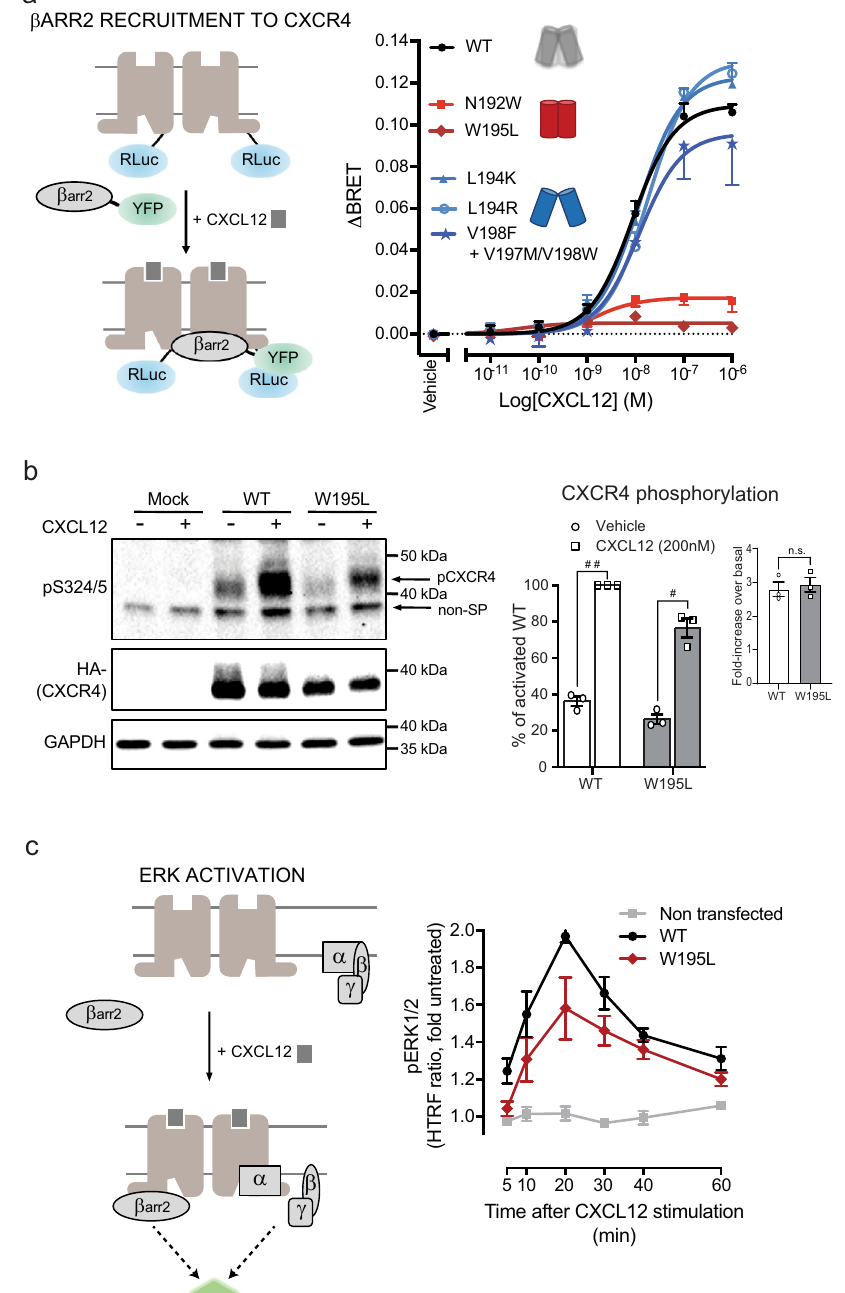
Fig. 4 | β -arrestin recruitment and ERK activation. a (Left) Schematic repre- sentation of the BRET-based ligand-induced β -arrestin-2 ( β arr2) translocation assay.(Right)CXCL12-promoted β arr2recruitmenttoCXCR4measuredbyBRETin HEK293TcellstransfectedwithCXCR4-RLuc,WTormutantasindicated,and β arr2- YFP. BRET 480-YFP between CXCR4-RLuc and β arr2-YFP was measured after the addition of coel-h (10min) and CXCL12 (15min). Data shown represent the mean±SEM of at least three independent experiments and are represented as Δ BRET. b (Left) Phosphorylation at S324/5 of WT and W195 5.34 L CXCR4 promoted by stimulation with 200nM CXCL12 for 30min detected using an anti pS324/5 antibody (pCXCR4 indicates the CXCR4-S324/5 phosphorylation band; non-SP correspond to a non-speci fi c band). (Right) Quanti fi cation of phosphorylation